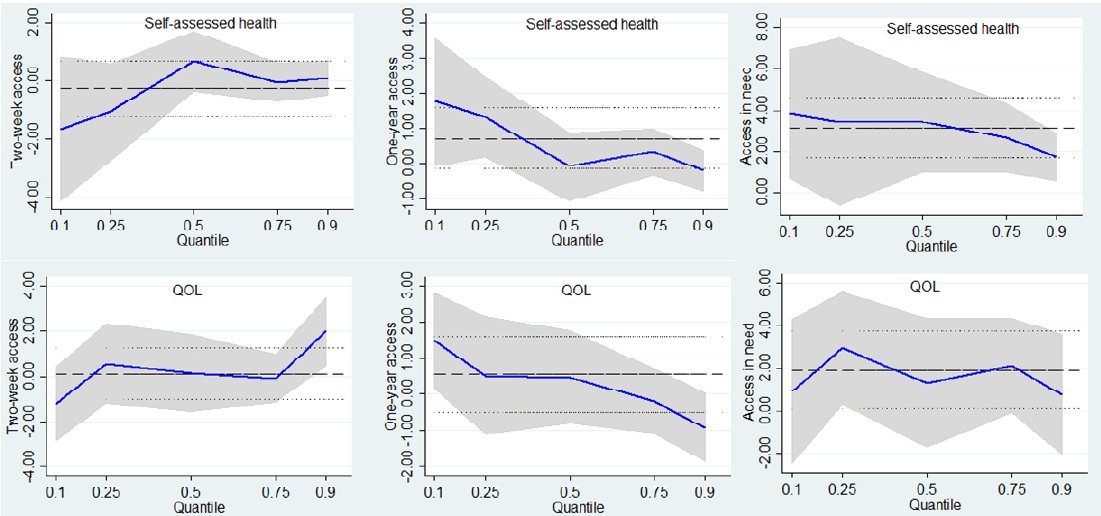
Figure 2. Point estimates and 95% confidence intervals from a quantile regression of the self-assessed health and QOL distribution for rural respondents.